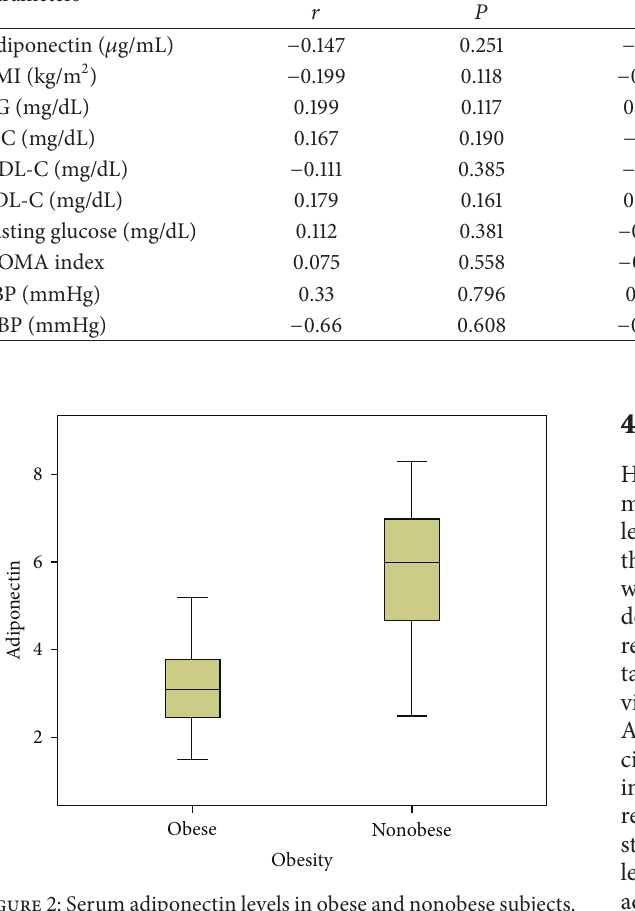
difference in adiponectin levels according to gender in the total study population (Table